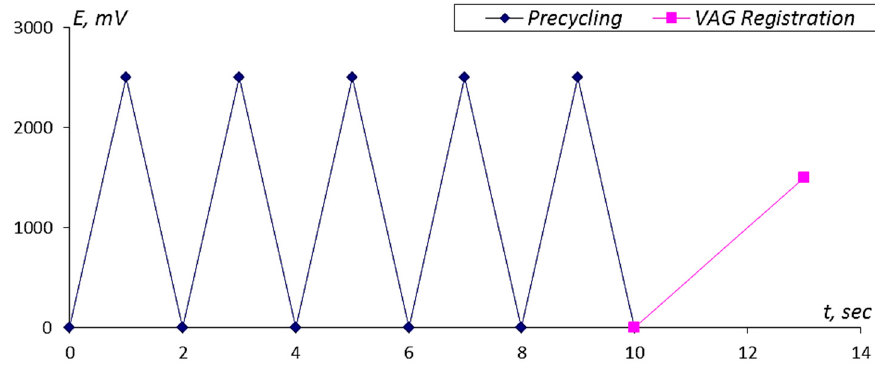
Figure 1. The scheme of the measurement cycle. The precycling procedure included five successive cycling stages with a potential scan rate of 2.5 V/s covering the potential range from 0–2.5 V. The voltammogram (VAG) curve of the analyzed solution was registered at a potential scan rate of 0.5 V/s, and the potentials ranged from 0–1.5 V. The time interval between measurements was 10 s. The period of the single VAG registration occupied 3 s. Table 2. The values of D -tryptophan added in the given buffer solute (the phosphate buffer solution (Na 2 HPO 4 + KH 2 PO 4 ) with рН 6.86).